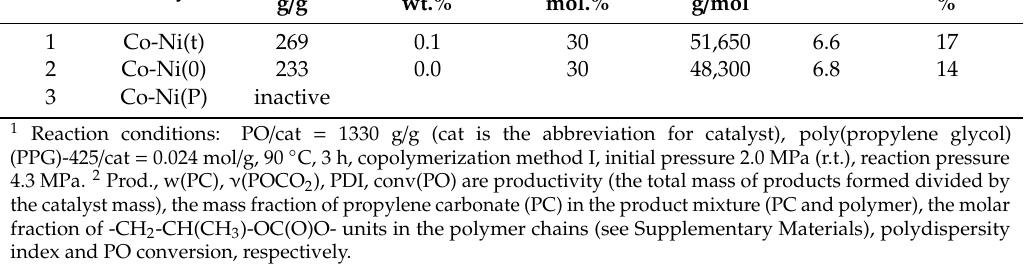
Table 2. Results of CO 2 / PO conversion in the presence of synthesized Co-Ni complexes.